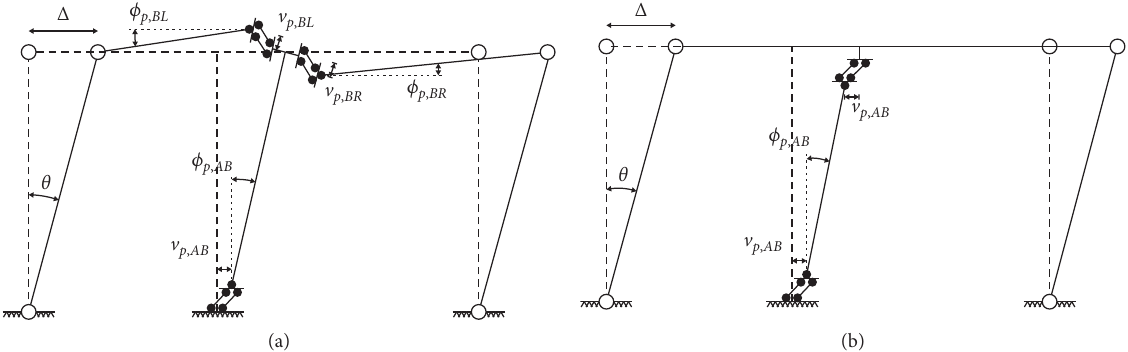
Figure 3: Modeling TRF-H system by considering the moment and shear interaction. (a) Mechanism “ A .” (b) Mechanism “ B